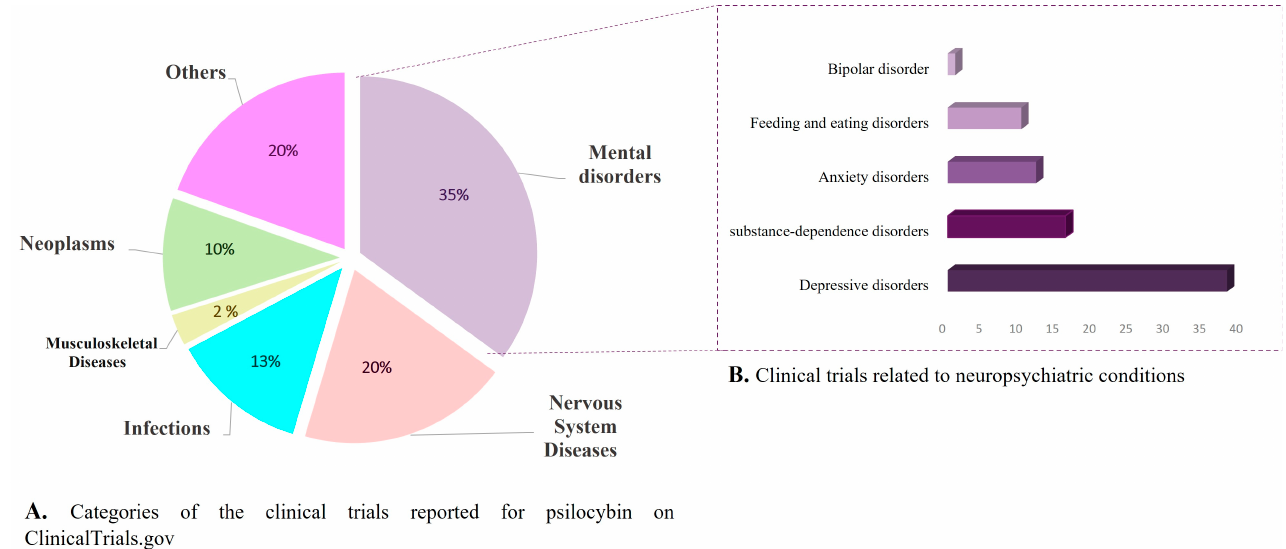
Figure 5. Distribution of psilocybin-related clinical trials registered on the ClinicalTrials.gov data base (https://clinicaltrials.gov accessed on 10 October 2022). base (https://clinicaltrials.gov accessed on 10 October 2022).